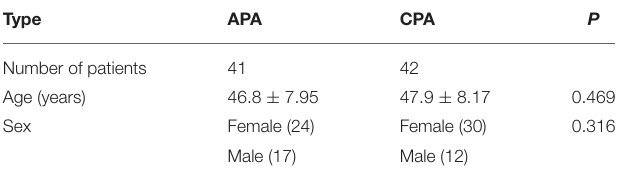
TABLE 1 | Demographic data of this